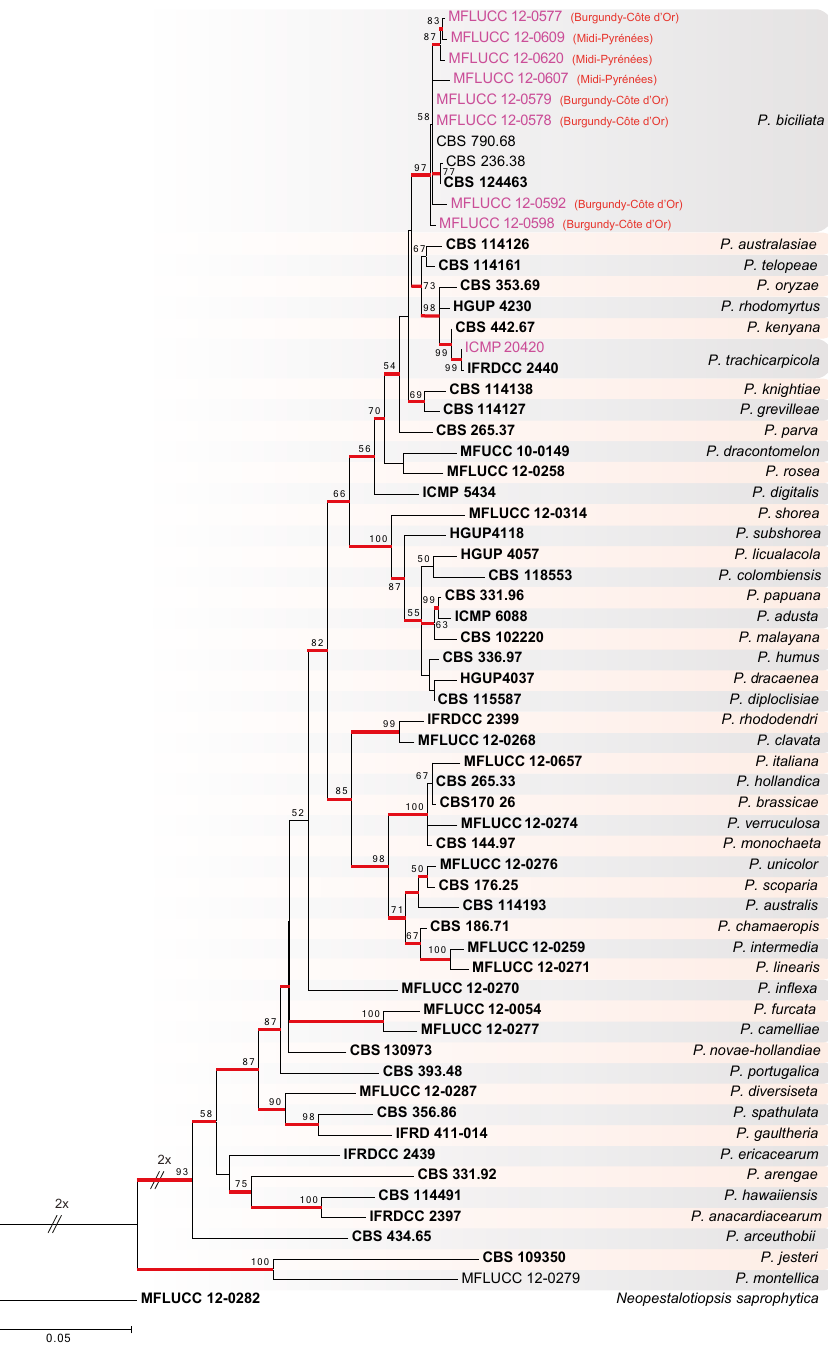
Figure 2. Consensus phylogram (50% majority rule) of 1,000 trees resulting from a RAxML analysis of ITS+TUB+TEF se- quence data from Pestalotiopsis species. Red-thickened lines indicate Bayesian posterior probabilities (PP) above 50% and RAxML bootstrap support values above 90% are given at the nodes. Sequences derived from ex-type are printed in bold type, and isolates derived from grapevine are printed in magenta and followed by the place of origin in France. The species name is indicated to the right of each clade. The scale bar represents the expected number of changes per site. The tree is rooted to Neopestalotiopsis saprophytica (MFLUCC 12-0282)